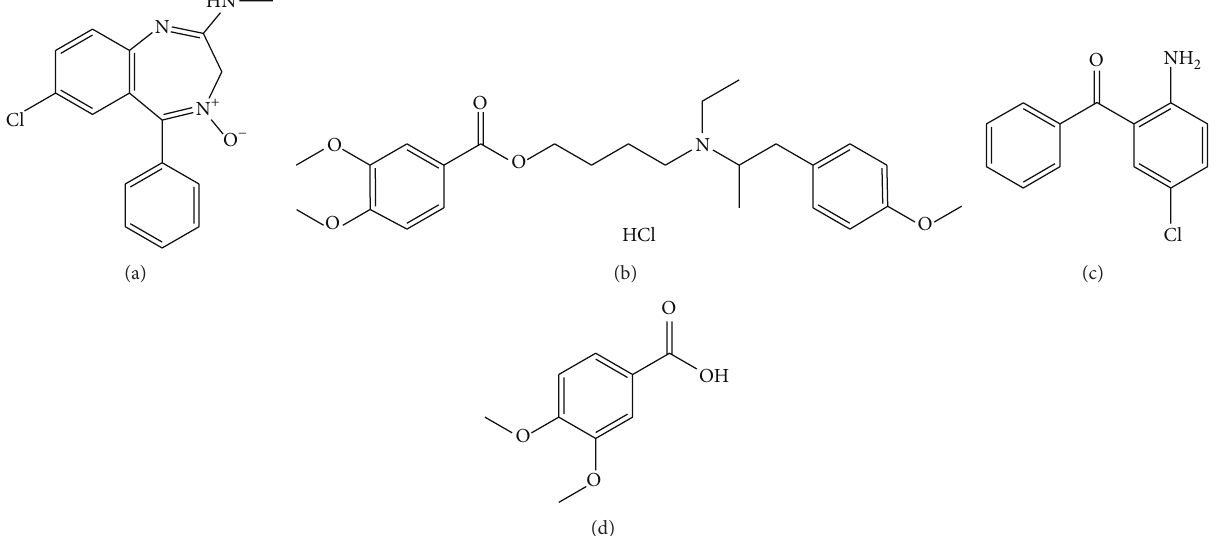
0.1 M perchloric acid and a spectrophotometric method for its determination in pure form and tablets, respectively.